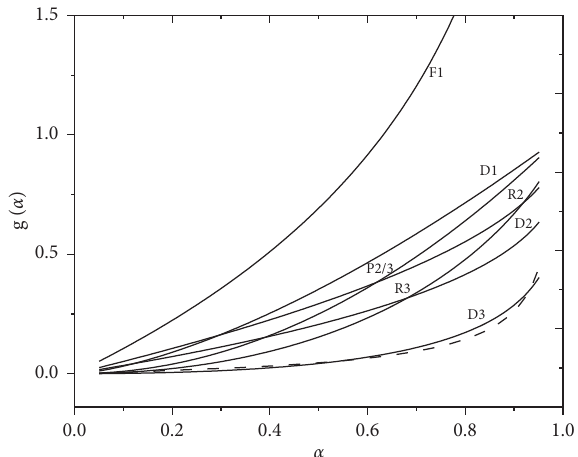
Figure 7: Theoretical curves g ( α ) as a function of α transformation for several kinetic models and the experimental graph for the kinetic model D3.